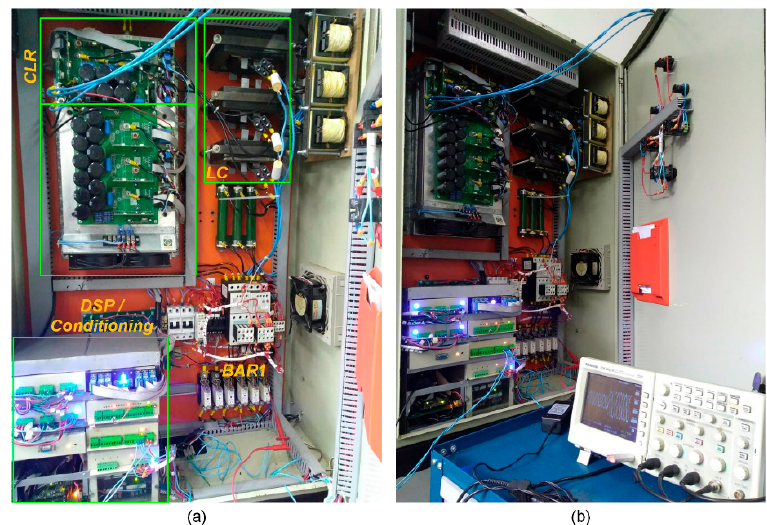
Figure 6. Experimental setup. ( a ) Building blocks. ( b ) External view under operation.